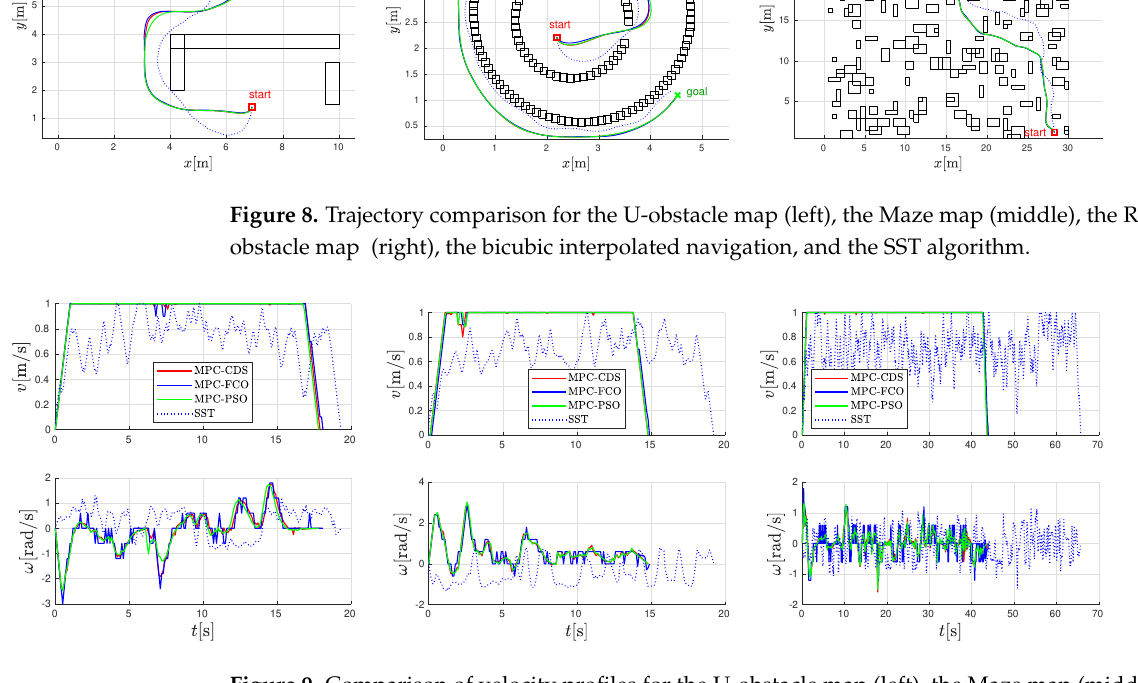
Figure 9. Comparison of velocity profiles for the U-obstacle map (left), the Maze map (middle), and the Random-obstacle map (right). Table 1. Algorithms validation on three different